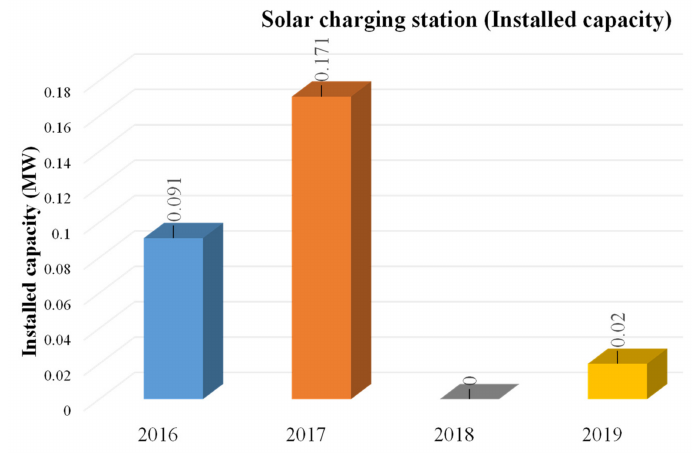
Figure 17. Historical yearly net installed capacity of solar charging stations in Bangladesh (authors’ creation based on SREDA data [21]).